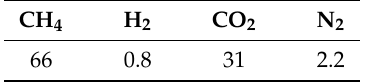
Table 3. Composition (% vol) of the biogas.